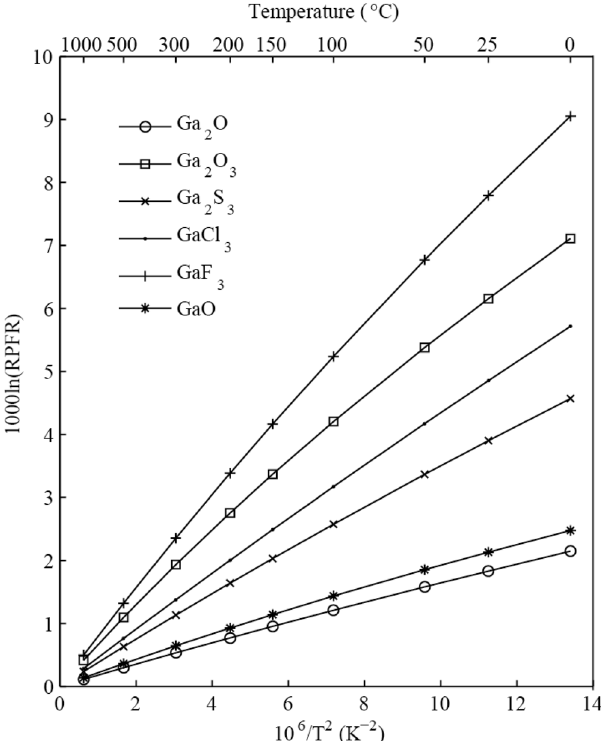
Figure 7. The l0 3 ln(RPFR)s of Ga 2 O, Ga 2 O 3 , Ga 2 S 3 , GaCl 3 , GaF 3 and GaO as a function of temperature at the basis set of B3LYP/6-311 + G(d) level.